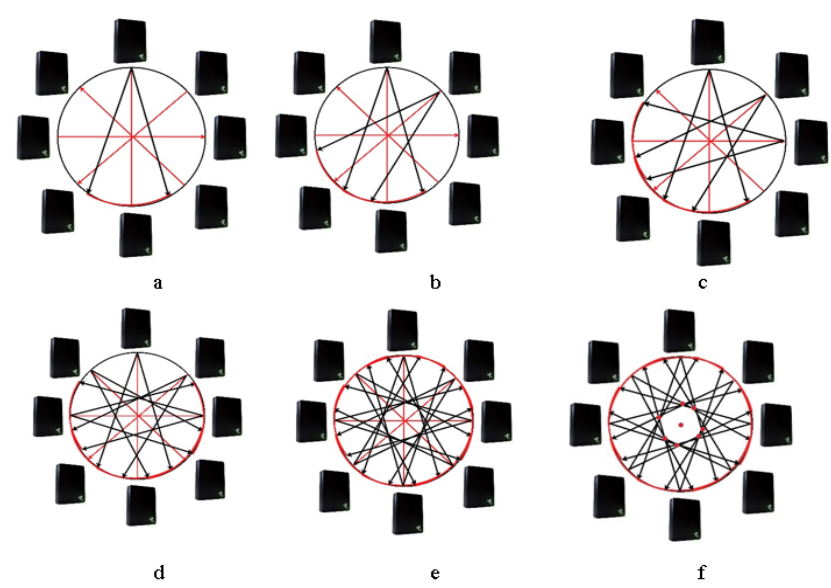
Figure 3. Circular Charger Placement.